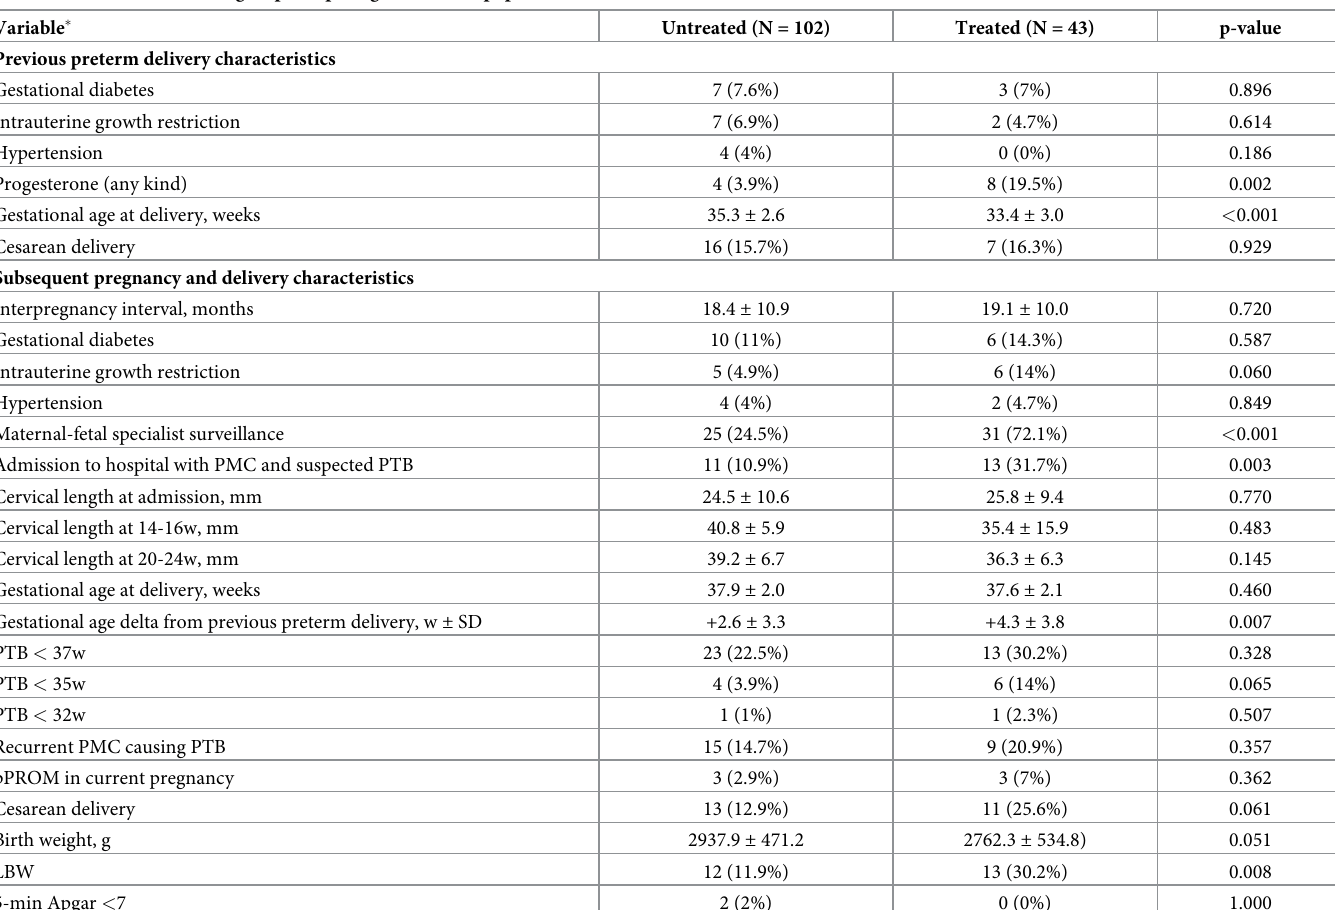
Table 1. Previous PMC-PTB group comparing 17P treated population vs. untreated. Variable